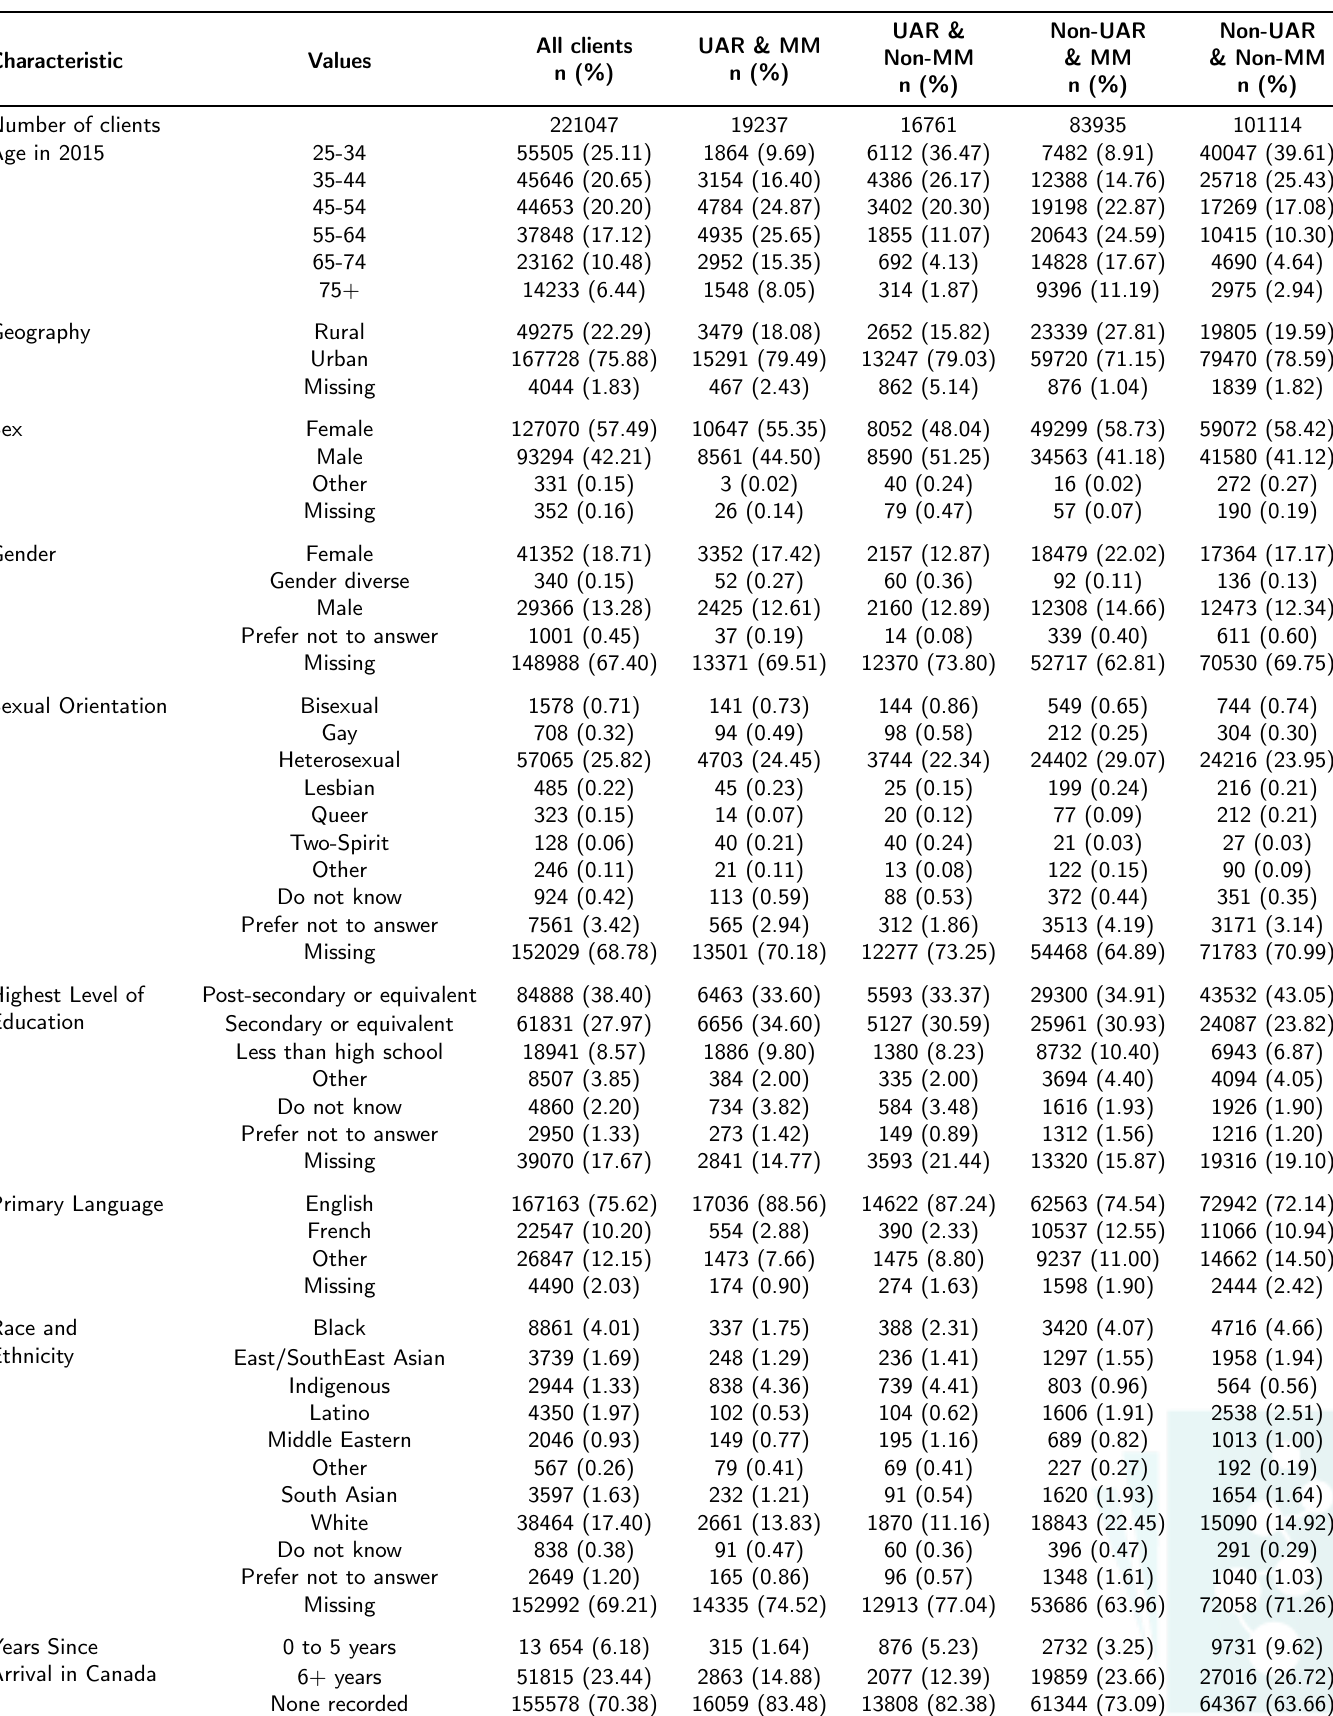
Supplementary Table 2: Sociodemographic characteristics with